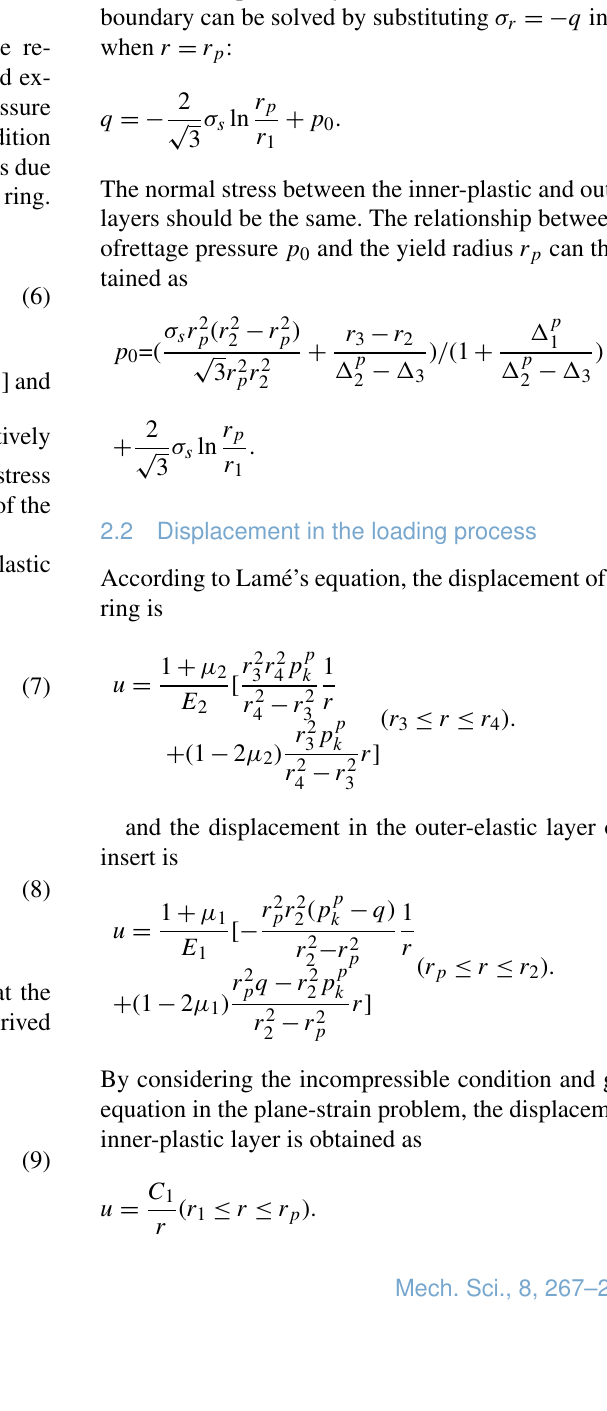
only related to internal pressure p 0 , and has nothing to do with the stress of elastic